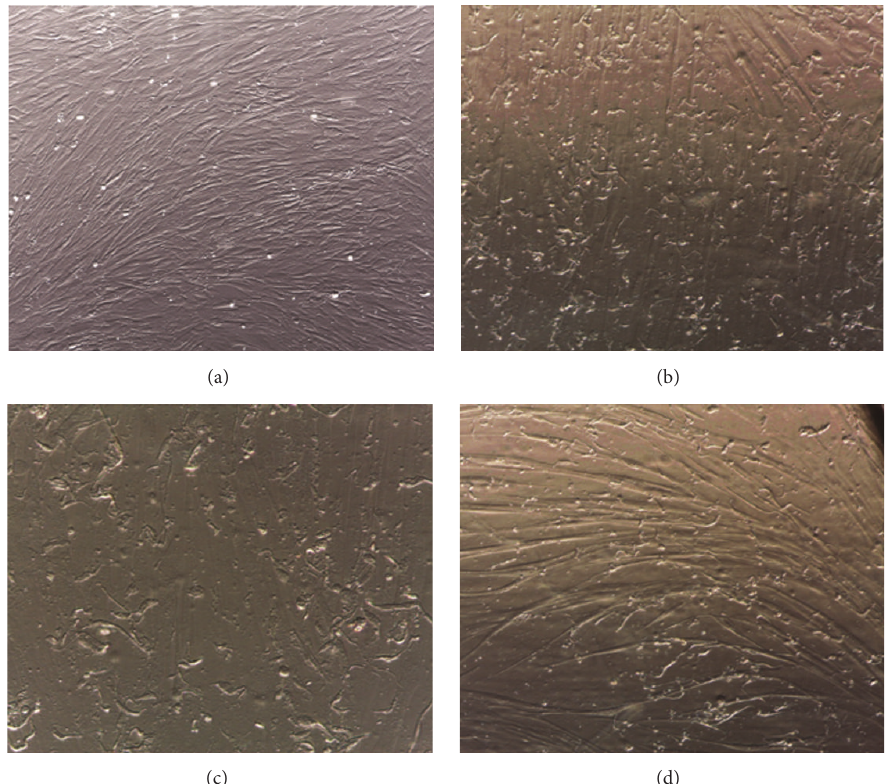
Figure 7: Cell morphological changes after differentiation into neural and glial cells. HA002 before differentiation (a) and after astrocyte differentiation (b), 100x magnification; HA006 after oligodendrocyte differentiation (c), 200x magnification; HA032 after neural differentiation (d), 200x magnification. Morphological cell changes were observed during neural and glial differentiation; cells developed multiple small irregular dendrite-like protrusions.